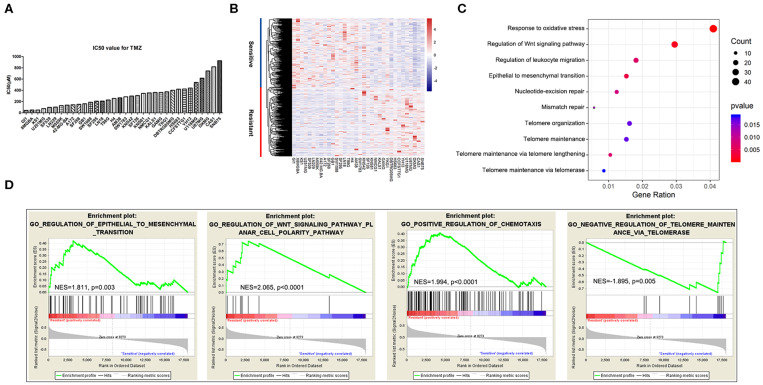
Genes and biological processes related to temozolomide (TMZ) response in glioblastoma (GBM). (A) IC50 value distribution of 34 glioma cell lines. (B) Heatmap of the expression of 1,373 TMZ sensitivity-related genes. (C) Enrichment of biological functions related to TMZ sensitivity using GO analysis. (D) Biological processes of TMZ response analyzed using the GSEA software.